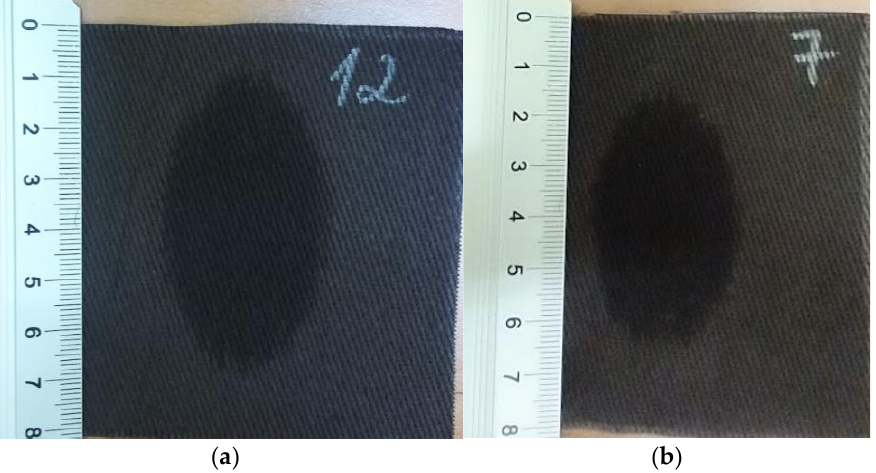
Figure 13. Comparison of liquid trace on variants with ( a ) 30 tex weft yarn and ( b ) 100 tex yarn. For each fabric variant, 10 repetitions of measurement were performed. After each test, a picture was taken. Due to this fact, we have 10 pictures of the liquid trace on the fabric surface for each fabric variant. The pictures were analyzed to determine the average diameters in both directions for each variant. In the presented pictures (Figure 13), the difference between diameters in the warp direction of both compared variants is ca. 1 cm.